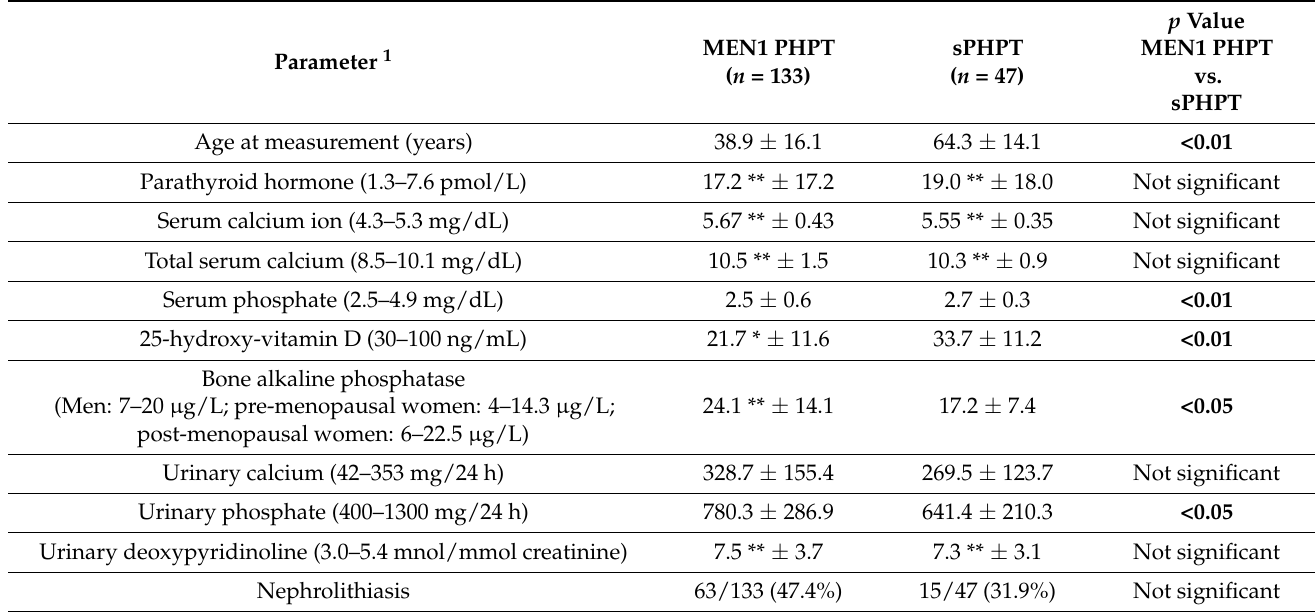
p Value MEN1 PHPT MEN1 PHPT sPHPT vs. ( n = 133) ( n = 47) sPHPT